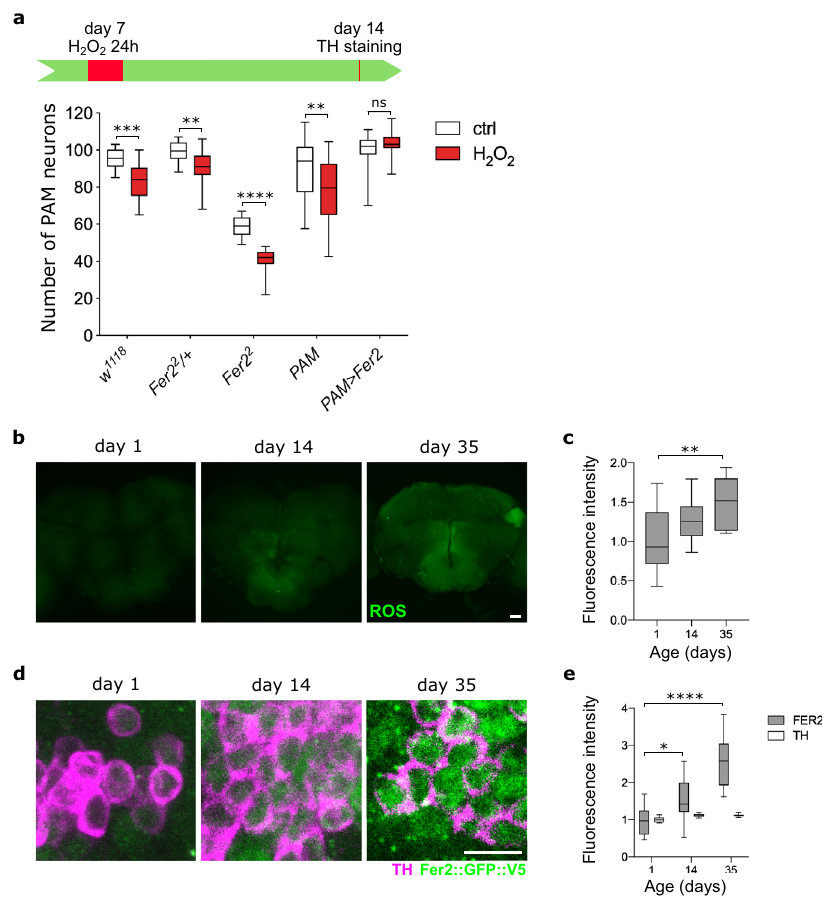
Fig. 2 Fer2 overexpression protects PAM dopaminergic neurons from oxidative insults. a w 1118 , Fer2 2 / + , Fer2 2 , R58E02-GAL4 ( PAM ) and PAM> Fer2 fl ies were fed with H 2 O 2 at day 7 for 24 h and the number of PAM neurons was examined at day 14. Fer2 mutation exacerbates, whereas Fer2 overexpression prevents, H 2 O 2 -induced PAM neuron loss. n = 16 hemispheres per group. Two-tailed Mann – Whitney test, ** p < 0.01, *** p < 0.001, **** p < 0.0001. w 1118 control (ctrl) vs. H 2 O 2 , p = 0.001. Fer2 2 / + ctrl vs. H 2 O 2 , p = 0.0076. PAM ctrl vs. H 2 O 2 , p = 0.0032. ns, not signi fi cant. b ROS levels in w 1118 fl ies at different ages were monitored using H2DCF dye. Scale bar, 25 μ m. c Quanti fi cation of ROS levels in the central brain from ( b ). Data are represented as fold change relative to day 1. n = 14 hemispheres per group. One-way ANOVA followed by a Tukey ’ s test for multiple group comparison, ** p < 0.01. day 1 vs. day 35, p = 0.0048. d Brains of Fer2::GFP::V5 fl ies of different ages were stained with anti-GFP (green) and PAM neurons were detected by anti-TH antibodies (magenta). Scale bar, 5 μ m. e GFP and TH fl uorescence intensities in the PAM region from ( d ) were quanti fi ed. Data are represented as fold change relative to day 1. n = 16 hemispheres per group. One-way ANOVA followed by a Tukey ’ s test for multiple group comparison, * p < 0.05, **** p < 0.0001. day 1 vs. day 35, p = 0.0117. Box boundaries in ( a ), ( c ) and ( e ) are the 25th and 75th percentiles, the horizontal line across the box is the median, and the whiskers indicate the minimum and maximum